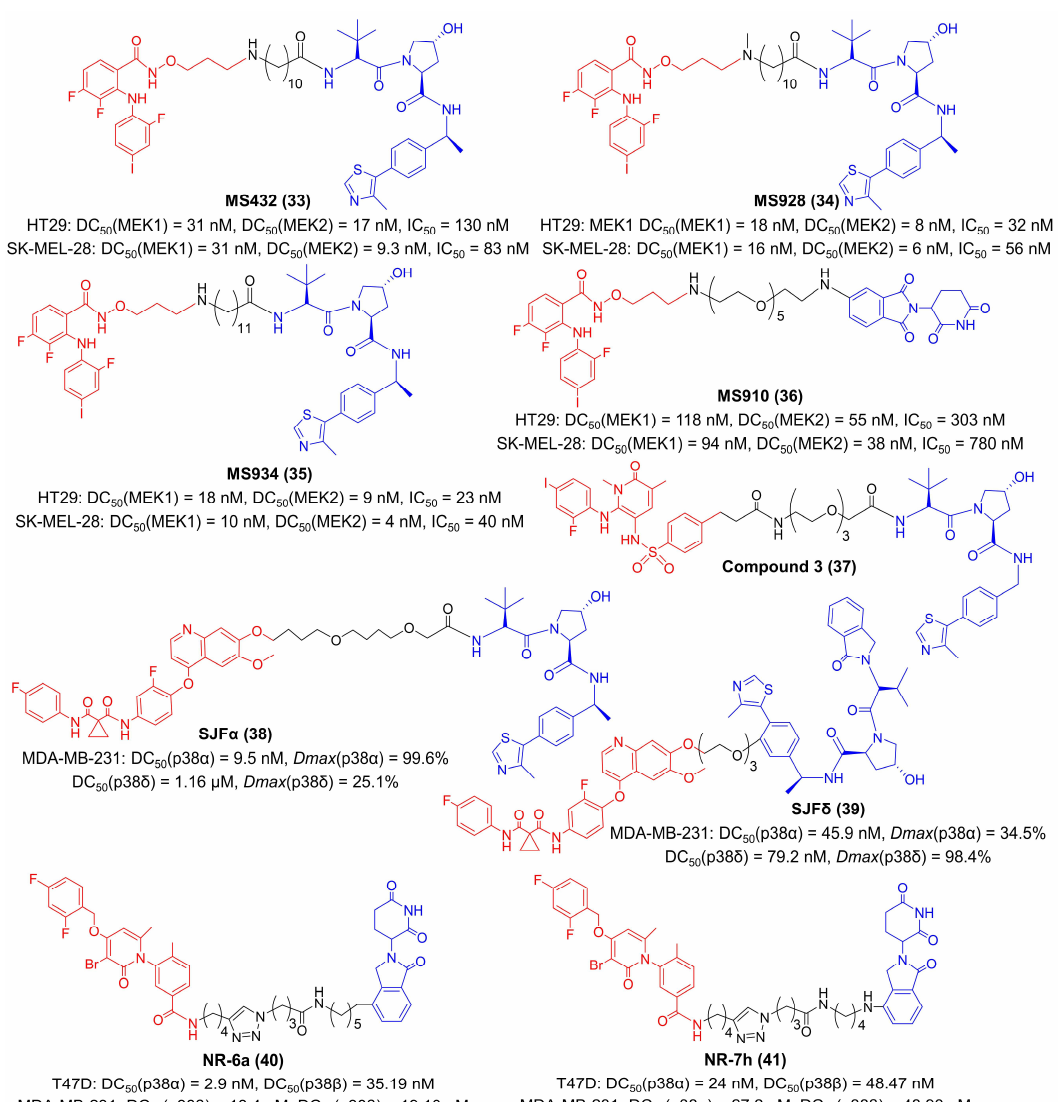
Figure 7. The chemical structures of representative PROTACs targeting MAPK. DC 50 —half-maximal degradation concentration; Dmax —maximum degradation; IC 50 —half-maximal inhibition concentration.